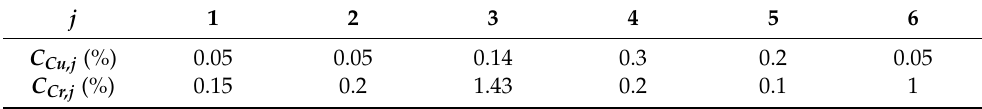
Table 2. Average concentration of Cu and Cr in scrap, C Cu , j and C Cr , j in six scrap types ( x j ).